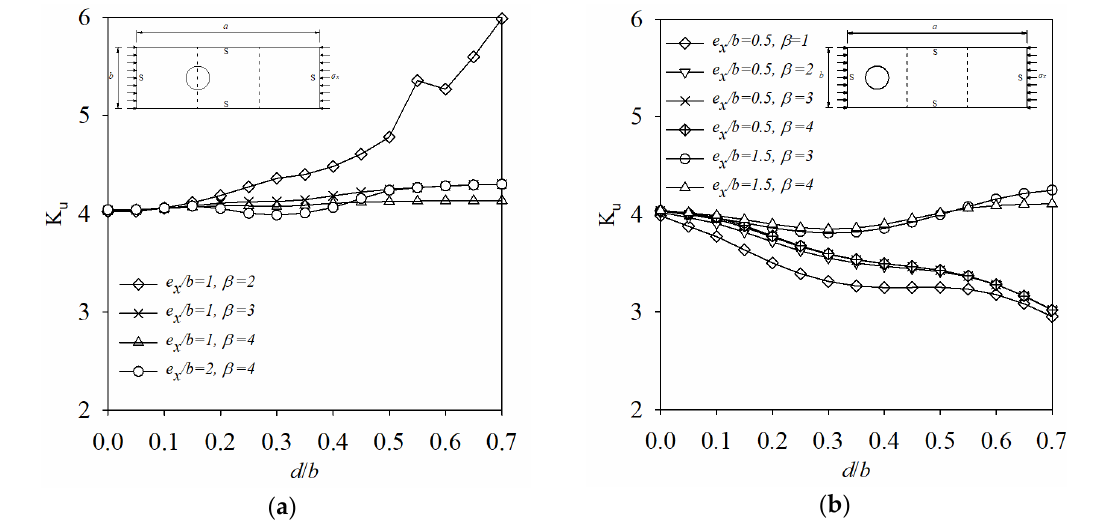
Figure 20. K u vs. d / b with BCs of 4S. ( a ): e x / b = 1 and 2; ( b ): e x / b = 0.5 and 1.5.